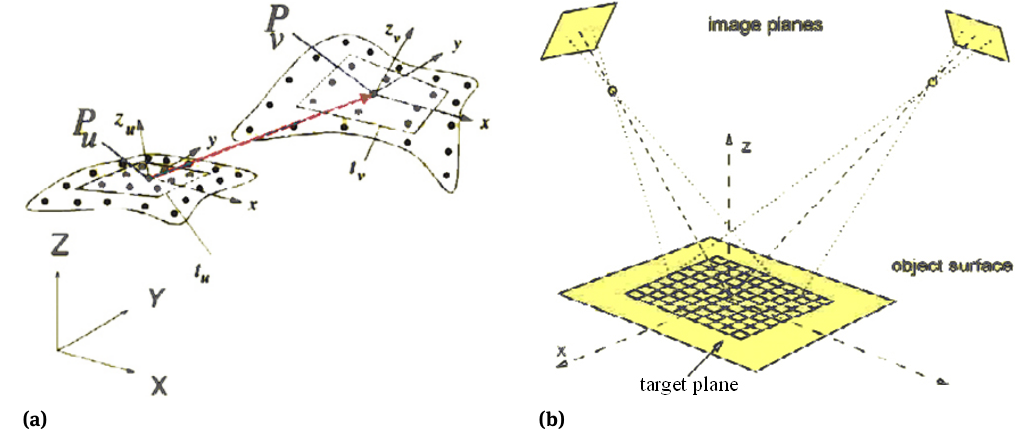
Figure 11: Determination of the three-dimensional displacement vector (a). Principle of 3D image correlation with 2 cameras (b)